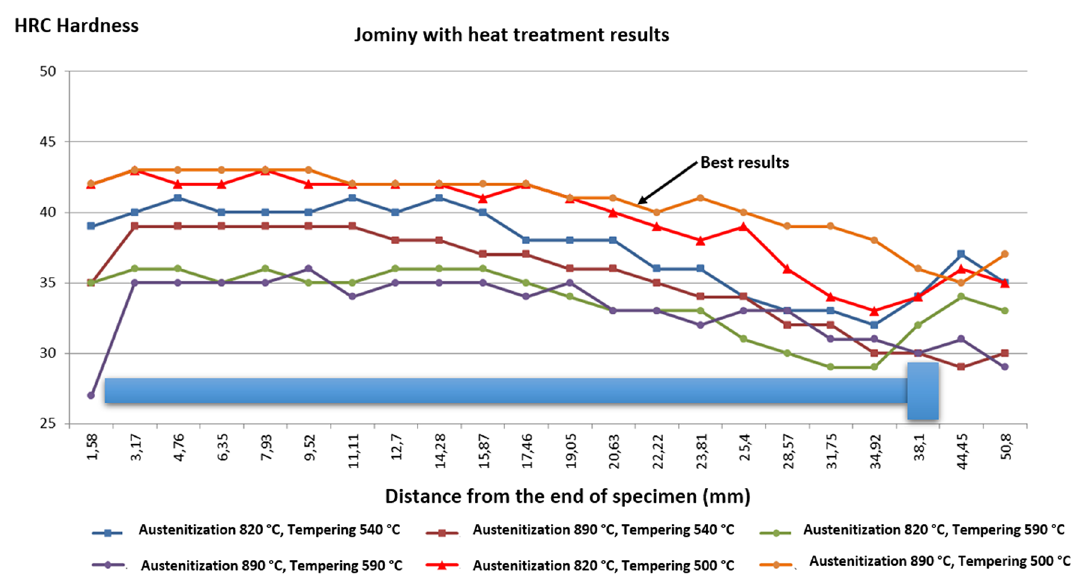
Figure 5. Results of the Jominy test after different heat